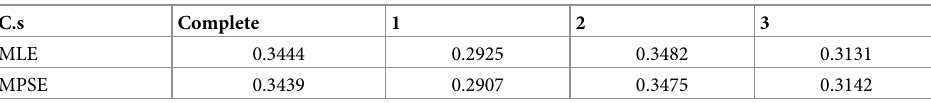
Figs 10–13 show that the estimated PDF of the IWD is a good fit for both data sets 1 and 2. The estimates of θ are calculated with effective sample sizes m = 26, m = 22. The three 1 2 adaptive type-II progressive hybrid censoring schemes for the simulation study are used to generate adaptive type-II hybrid progressive censored samples, the associated stopping time for each scheme and the generated censored samples are given in Table 18. The estimates of θ are calculated for the complete case and the three censoring scheme with effective sample sizes m = 26, m = 22. Results are summarized in Table 19. I is notable that θ 1 2 is less than 0.5 for both estimates, which means that data 2 has a higher probability of having longer survival times than data 1. Moreover, estimates of θ based on the adaptive type-II hybrid progressive samples are close to those of complete data.